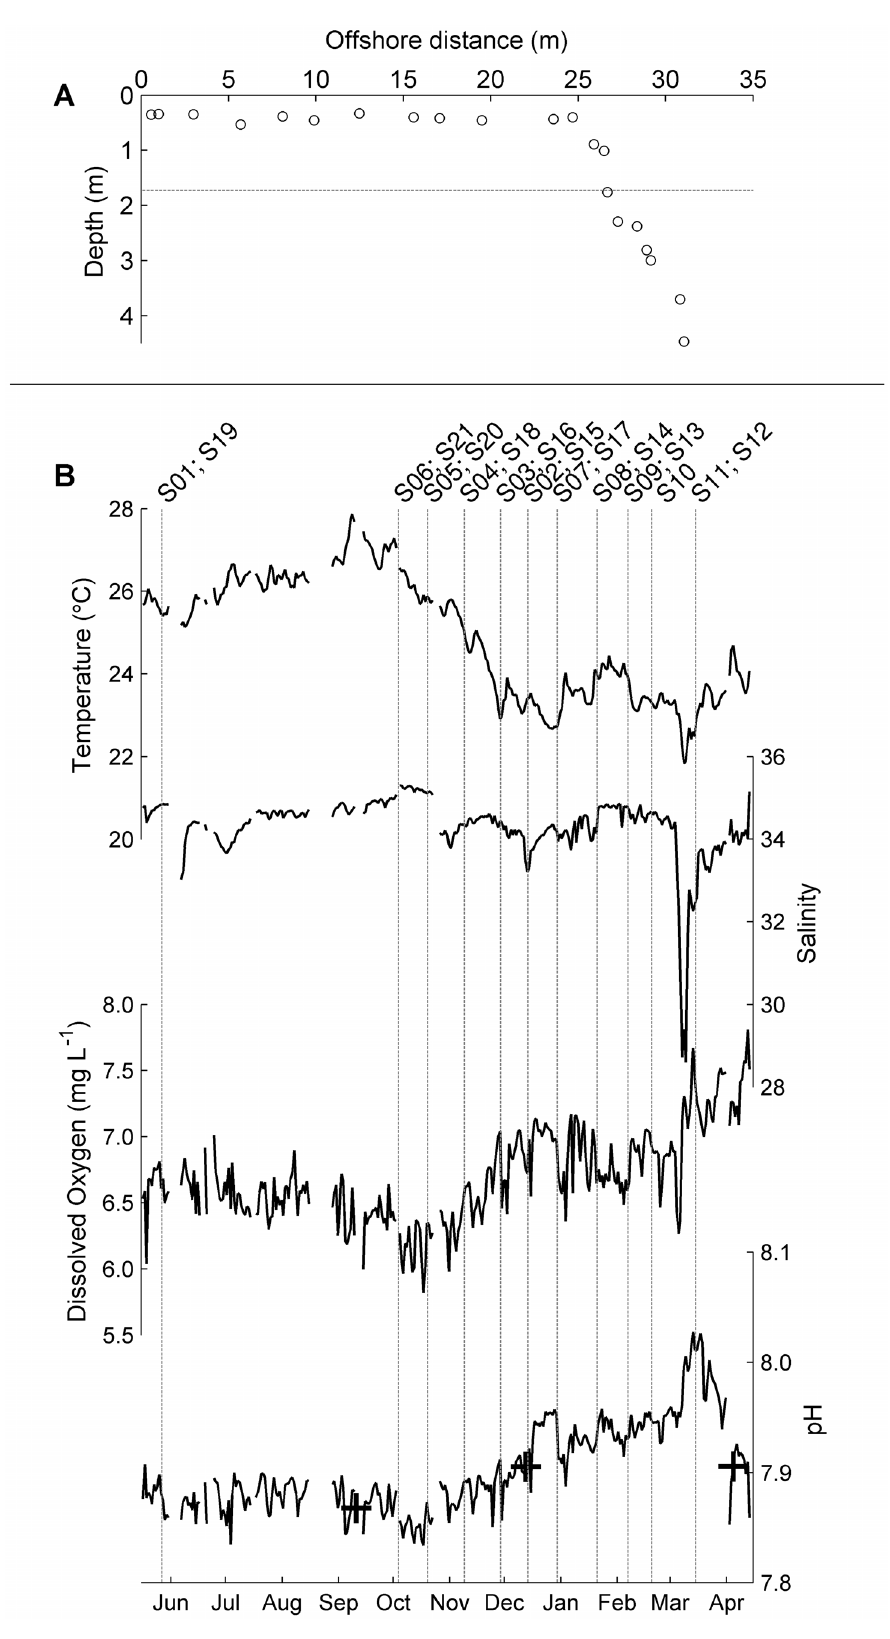
Figure 1. Timing and position of sensor deployments. (A) Position of sites in the reef-flat to reef-slope transect on distance to shore-depth axes. Sites are numbered consecutively (S1–S21) from left to right. Horizontal dotted line marks the depth at which the long-term time series was